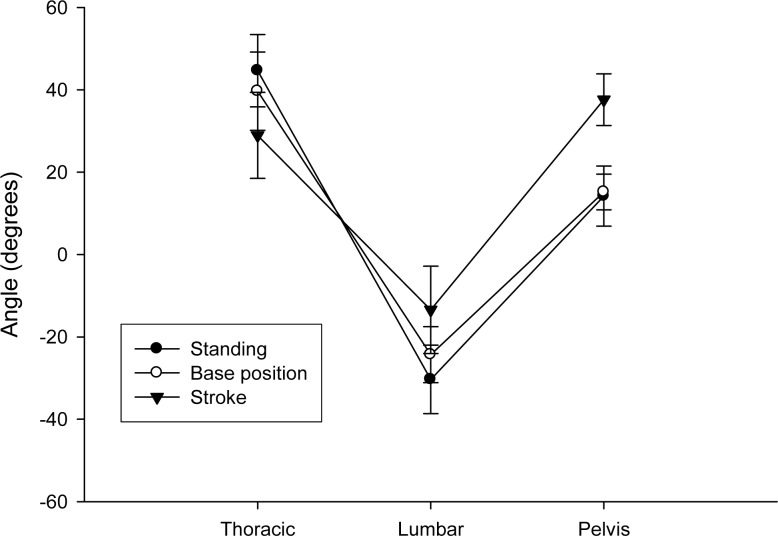
Mean (±SD) of the spinal curvatures and pelvic inclination while standing and in the boat